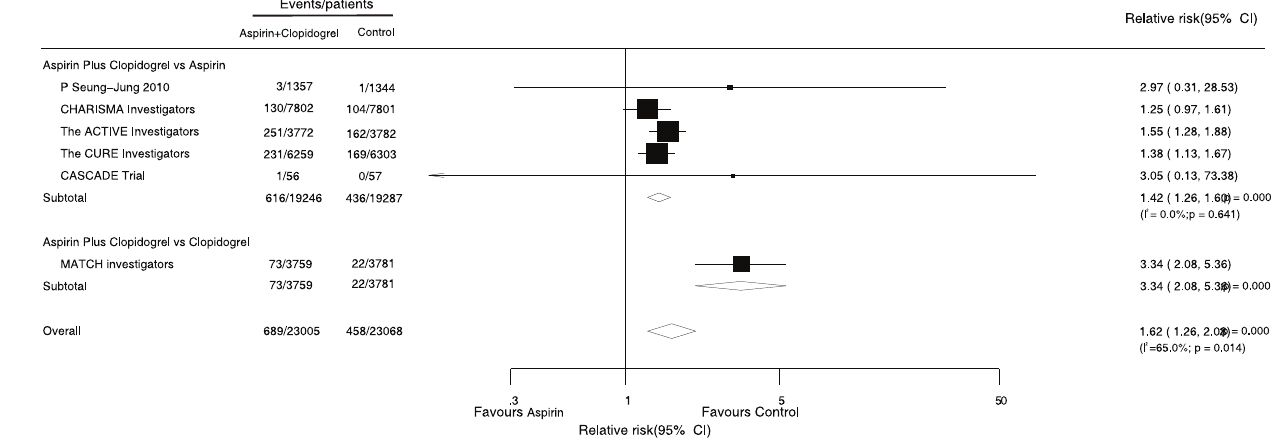
Figure 5. Effects of aspirin with clopidogrel therapy on risk of major bleeding events.